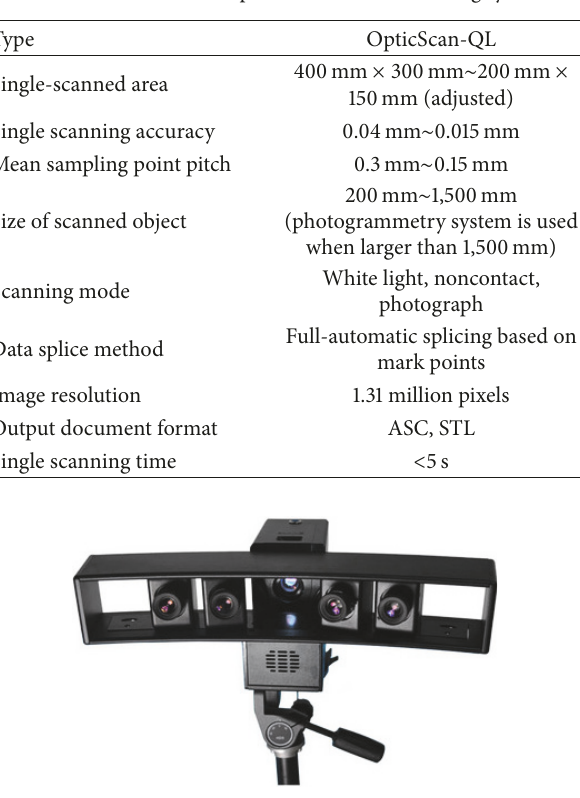
Table 3: Technical characteristics of SB102 optical plate.